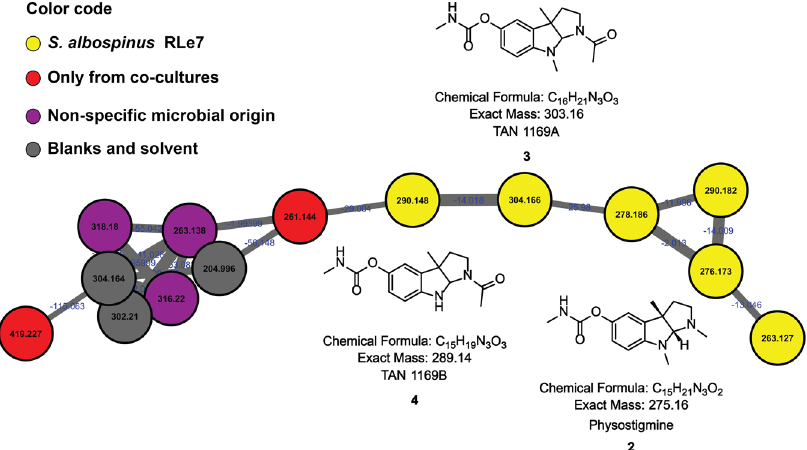
Figure 2. Pyrroloindole alkaloids-cluster from the molecular network of interactions among endophytic microorganisms from L . ericoides . Nodes from co-cultures are red, nodes from several strains (non-specified microbial origin) are purple, nodes observed in mono- and co-cultures involving S . albospinus RLe7 are in